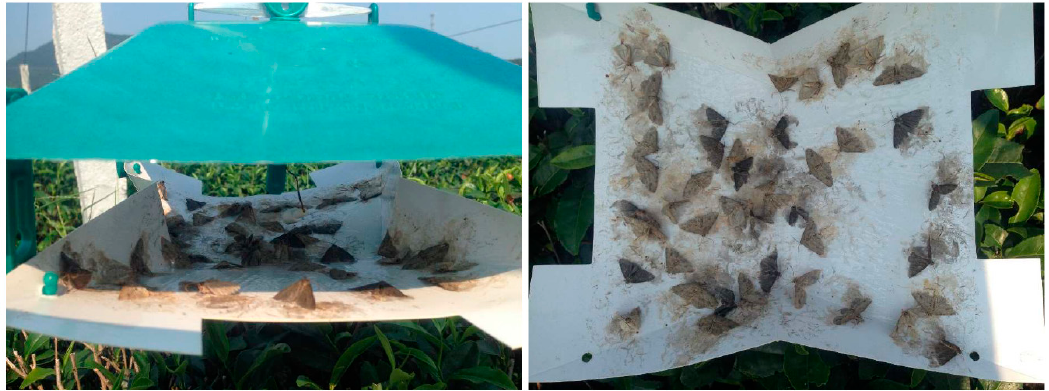
Figure 8. Mass trapping performance of sex pheromone lure of Ectropis grisescens .